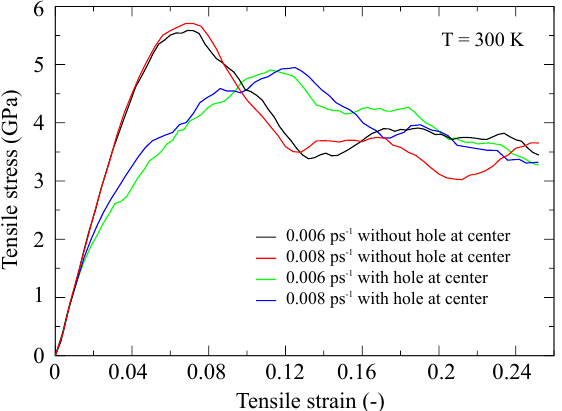
Figure 6. Stress-strain curves for model with and without hole at the